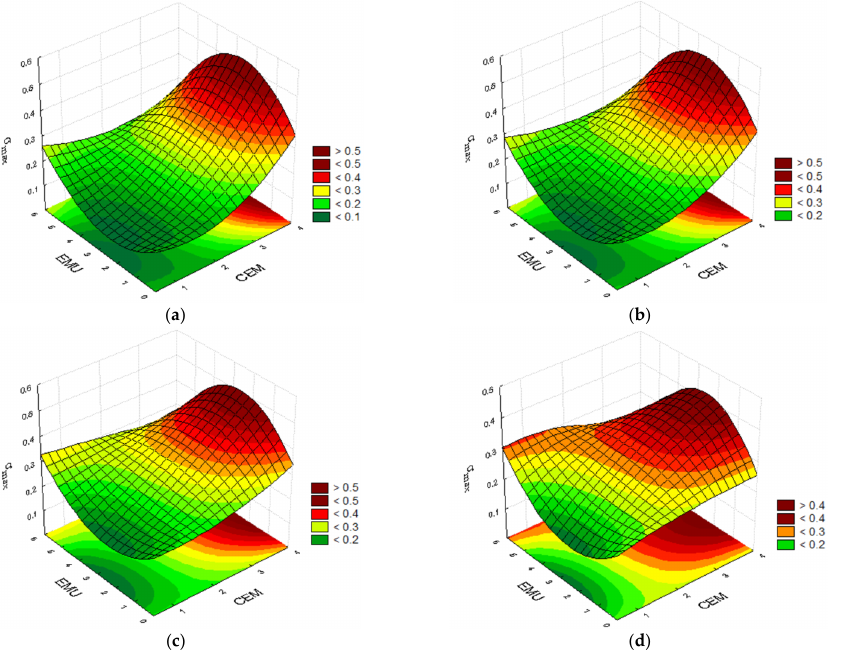
Figure 6. Plots for the stress at break σ max at the temperature of 0 °C, taking into consideration the cement and bitumen emulsion contents and the polymer modifier content of ( a ) 0.0%; ( b ) 0.5%; ( c ) 2.0%; and ( d ) 3.5%. The stress at break σ max test conducted at 0 °C demonstrated that the recycled mixture’s cement content is a very important parameter. The highest results were obtained for cement content of 3.5% and emulsion content of 2.0%. The addition of polymer into the mixture results in equally high stress at break σ max with simultaneous reduction in cement content. Advantageous results can be obtained in a broader range of mixture component dosage. The results obtained at the temperature of 20 °C confirm the assumption. The recycled mixture containing 3.5% of cement, 3.5% of polymer, and 2.5% of bitumen emulsion achieved the same result as the mixture with 3.5% of cement, 2.0% of polymer and 5.0% of bitumen emulsion, i.e., σ max = 0.29. The modifier content in the mixture can help reduce the demand for the asphalt binder. The mixture containing 2.0% of cement and 3.5% of modifier, prepared without bitumen emulsion, achieved the result of σ max = 0.32. This confirms the possibility of reducing the bitumen emulsion content in the recycled subbase in favour of the modified polymer content. Figure 7 below presents the convergence surfaces for the conducted analysis.